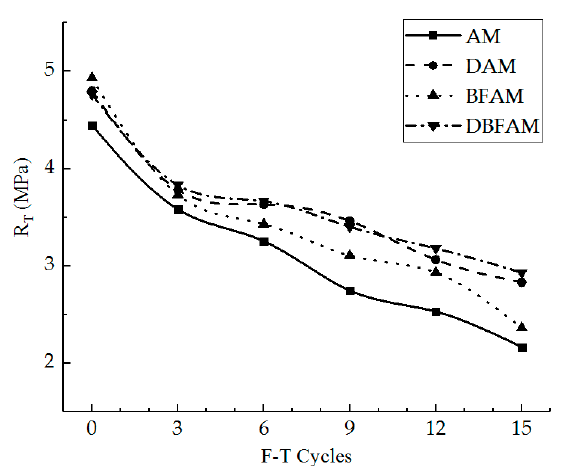
Figure 5. Indirect tensile (IDT) strength under F–T cycles. AM, Matrix asphalt mixture; DAM, diatomite-modified asphalt mixture; BFAM, basalt fiber-modified asphalt mixture; DBFAM, diatomite–basalt fiber-modified asphalt mixture.